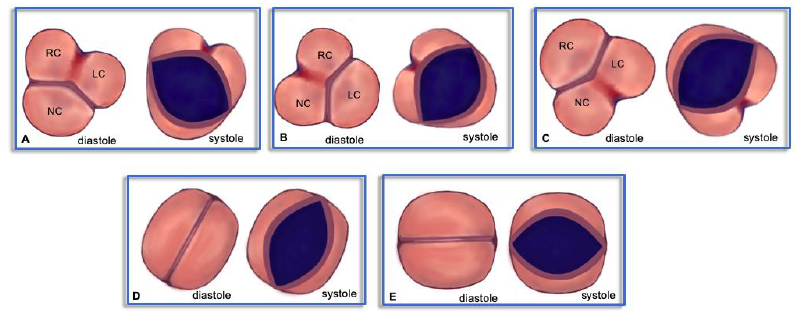
Figure 1. Schematic morphology of bicuspid aortic valve as seen by parasternal short-axis echocardio- graphic view. RC = right cusp, LC = left cusp, NC = noncoronary cusp. ( A ): fused type with right–left cusp fusion; ( B ): fused type with right noncoronary cusp fusion; ( C ): fused type with left noncoronary cusp fusion; ( D ): 2-sinus type with latero–lateral phenotype; ( E ): 2-sinus type with anteroposterior phenotype.